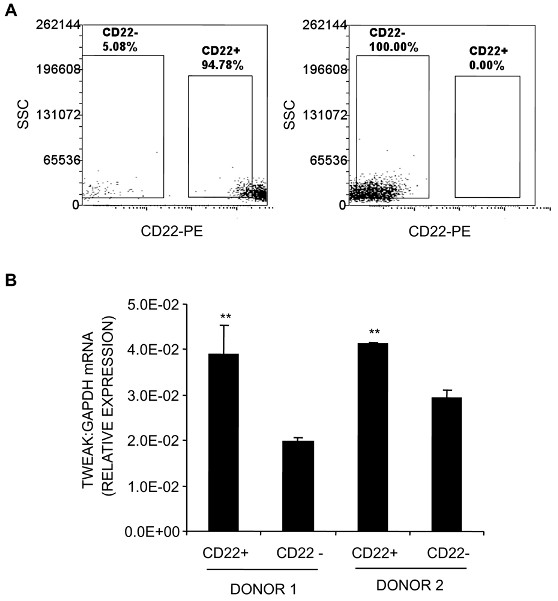
TWEAK expression by PBMC. PBMC from two healthy volunteers were sorted by FACS based on their expression of CD22, yielding CD22+ and CD22- populations of greater than 94% purity based on post-sort analysis (A). Isolated cells were then analysed for TWEAK mRNA expression relative to that of GAPDH, by real-time RT-PCR (B). Data shown are means of triplicate reactions ± SD. Differences in relative expression of TWEAK mRNA between CD22+ and CD22- populations were tested by Student's t-test (**P < 0.001).